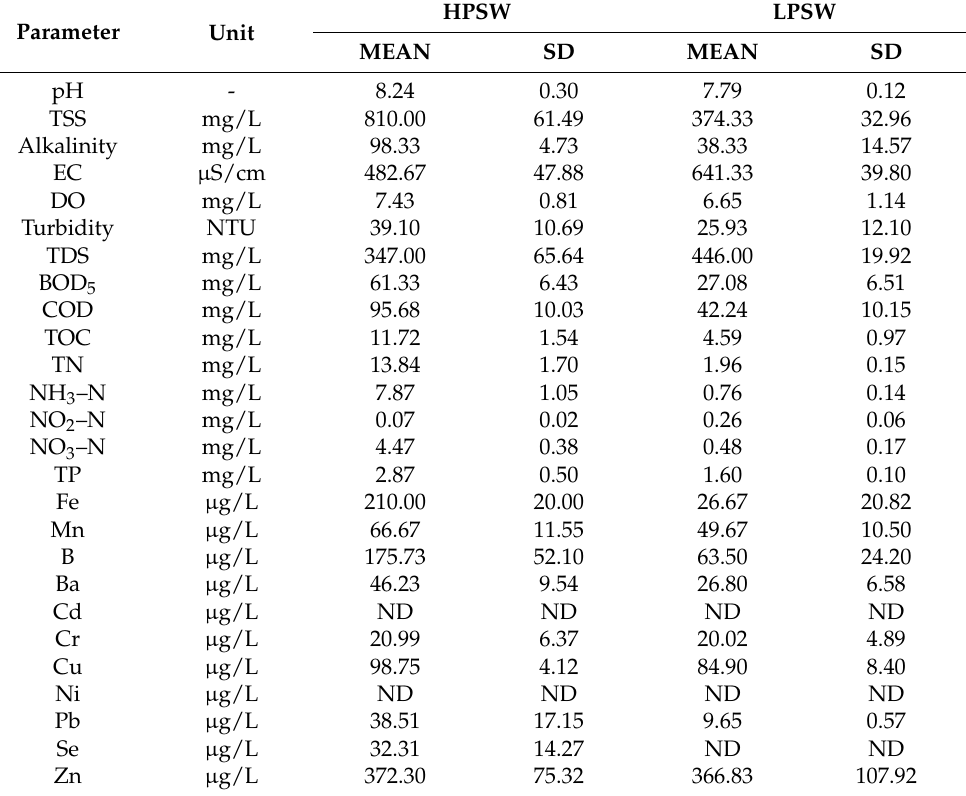
Table 3. Characteristics of two SWs strengths used in the infiltration